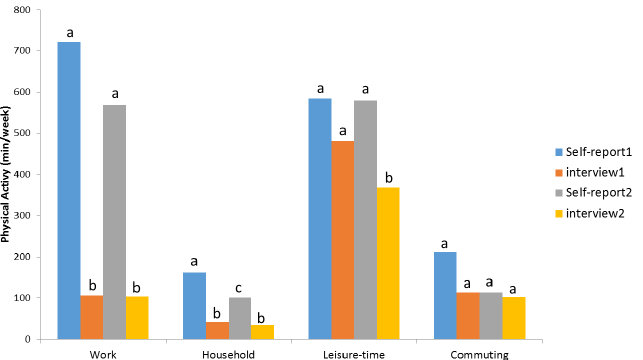
Figure 1. Mean PA scores in the domains of work, household, leisure-time and commuting (minutes/ week) measured via the long version of the IPAQ, in a habitual week (self-report1 and interview1) and in the last seven days (self-report2 and interview2) obtained via self-report and via trained interviewer ( n =38). Kruskal Wallis Test (work p < .001; domestic p = .02; leisure-time p < .002; commuting p > .05); different letters (“ a ”, “ b ” or “ c ”) determine significant